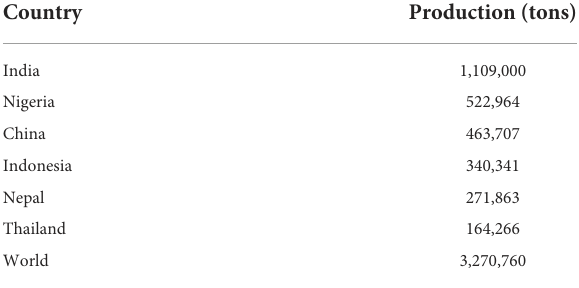
TABLE 1 Estimated global production of ginger ( Zingiber officinale